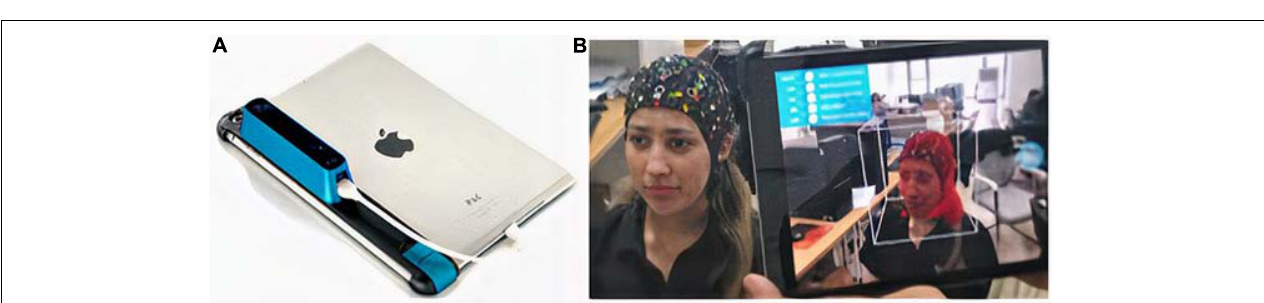
FIGURE 1 | Effects of sources on EEG sensors, the dependence on the electric field overlay, and the electrode positions.